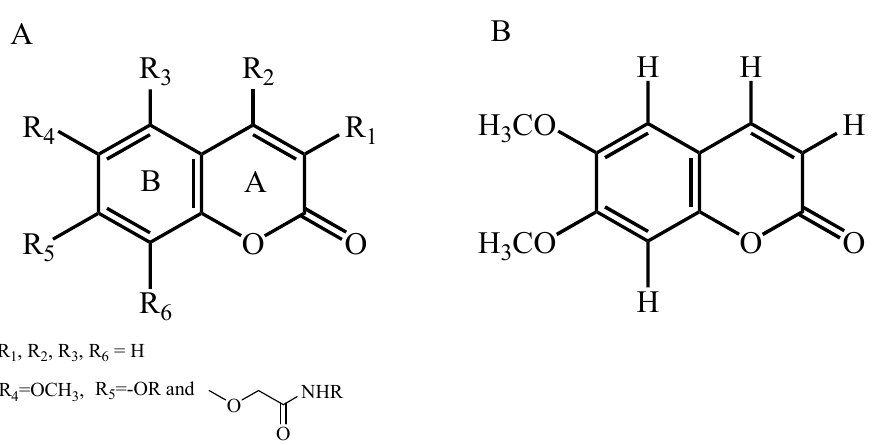
Figure 4. ( A ) The skeleton structure of the studied scopoletin phenolic ether derivatives and ( B ) the chemical structure of compound 8 .